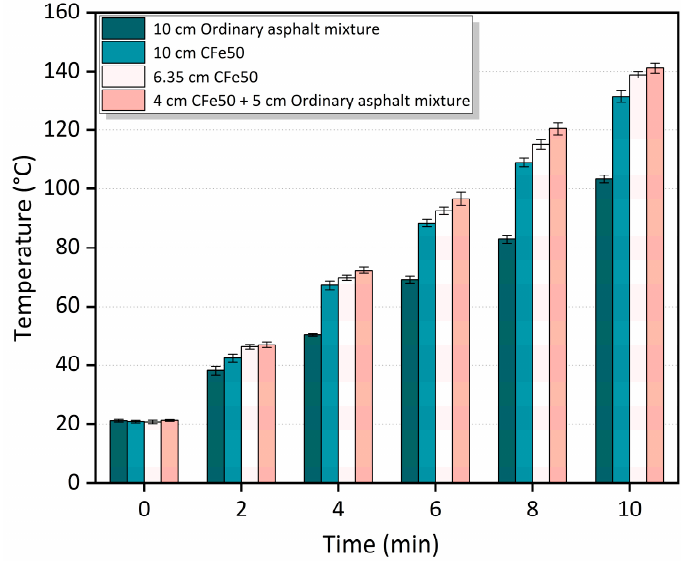
Figure 14. Temperature change for different thicknesses of the asphalt mixtures with a 50% replace- ment rate of CFe.